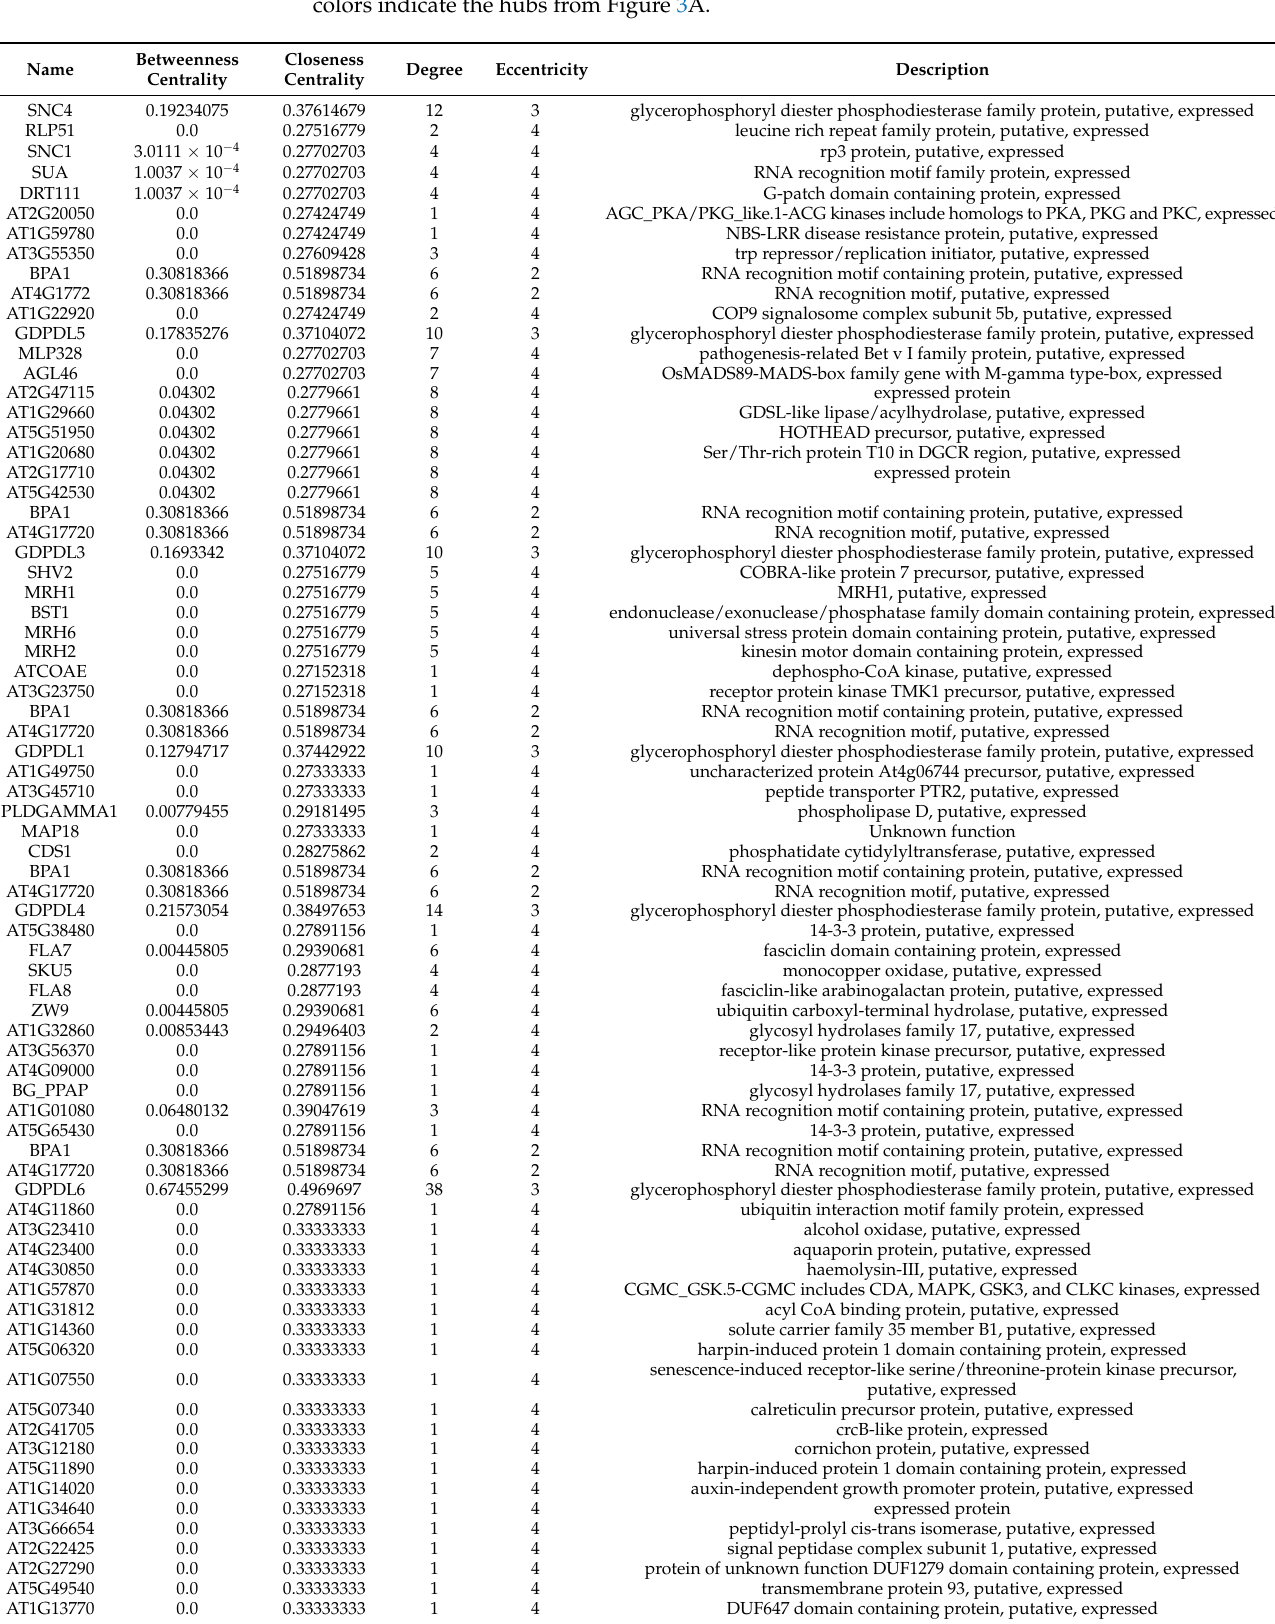
Table 11. Protein-protein interactions between the GDPDL proteins and Arabidopsis proteins. The colors indicate the hubs from Figure